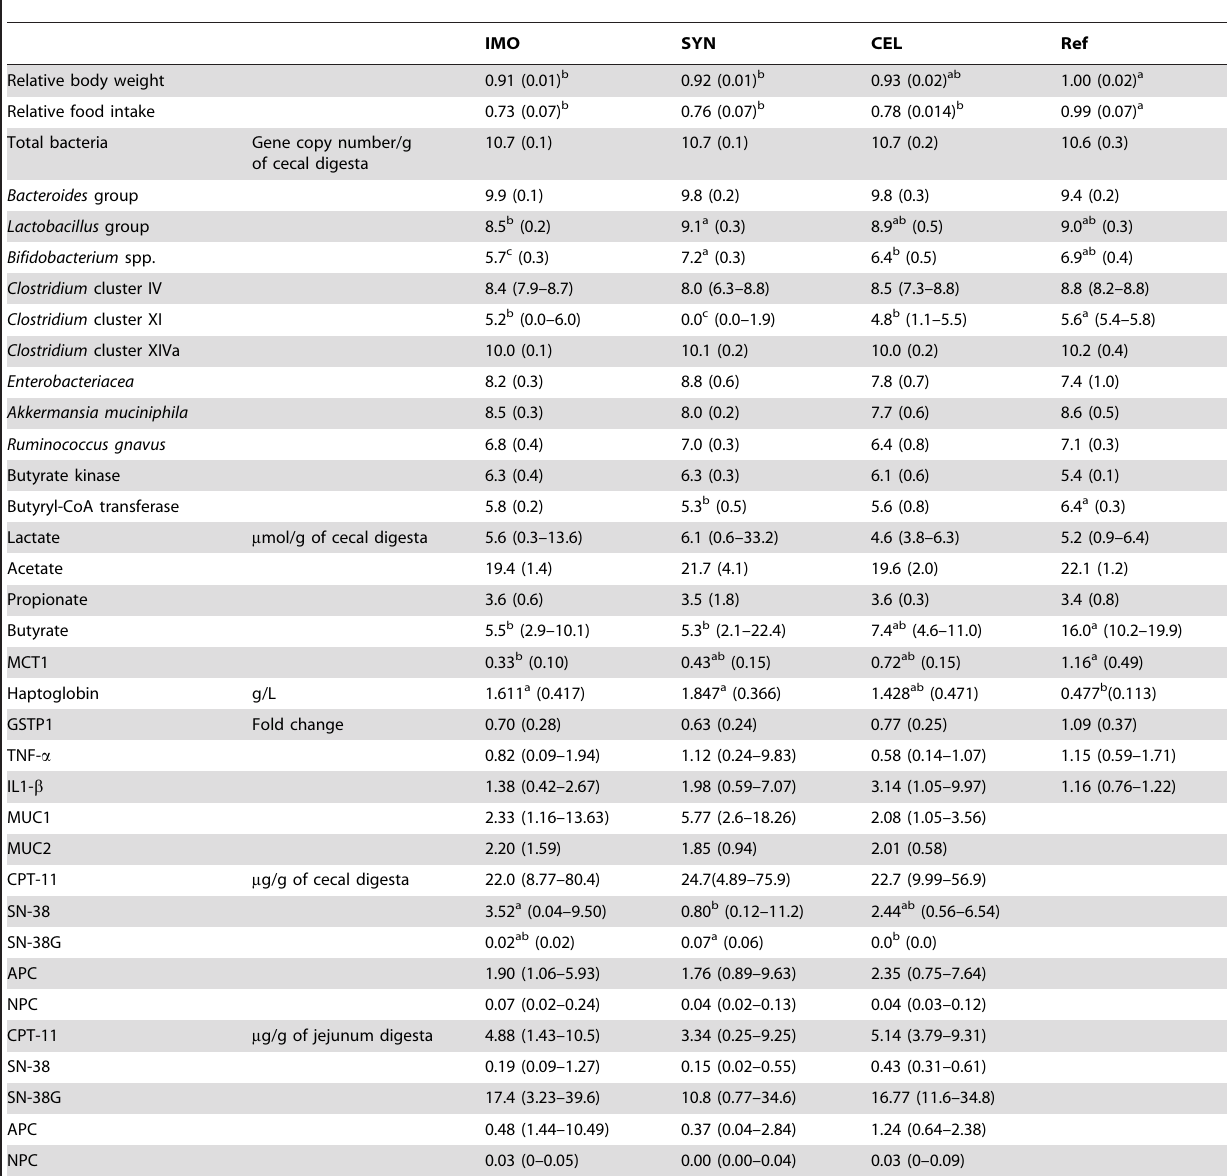
Table 2. Abundance of major bacterial groups, stress response, MCT1 expression, SCFA concentration, and CPT-11 metabolite concentrations per gram of cecal digesta in Exp